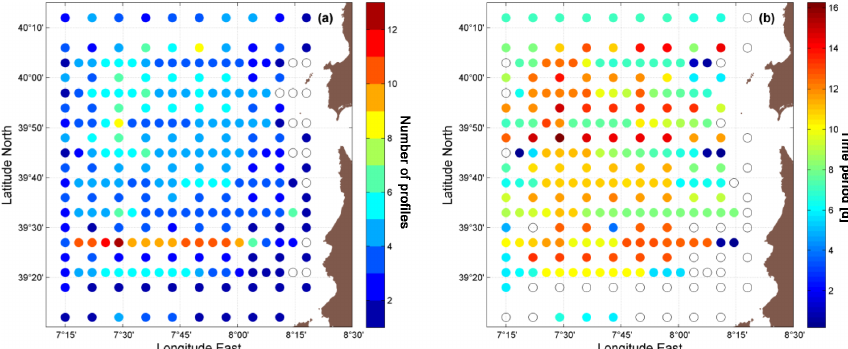
Figure 10. (a) Number of profiles gathered for each grid station (stations with no assigned profiles in white), and (b) time period in days between the first and last profile assigned to each grid station (stations with only one profile in